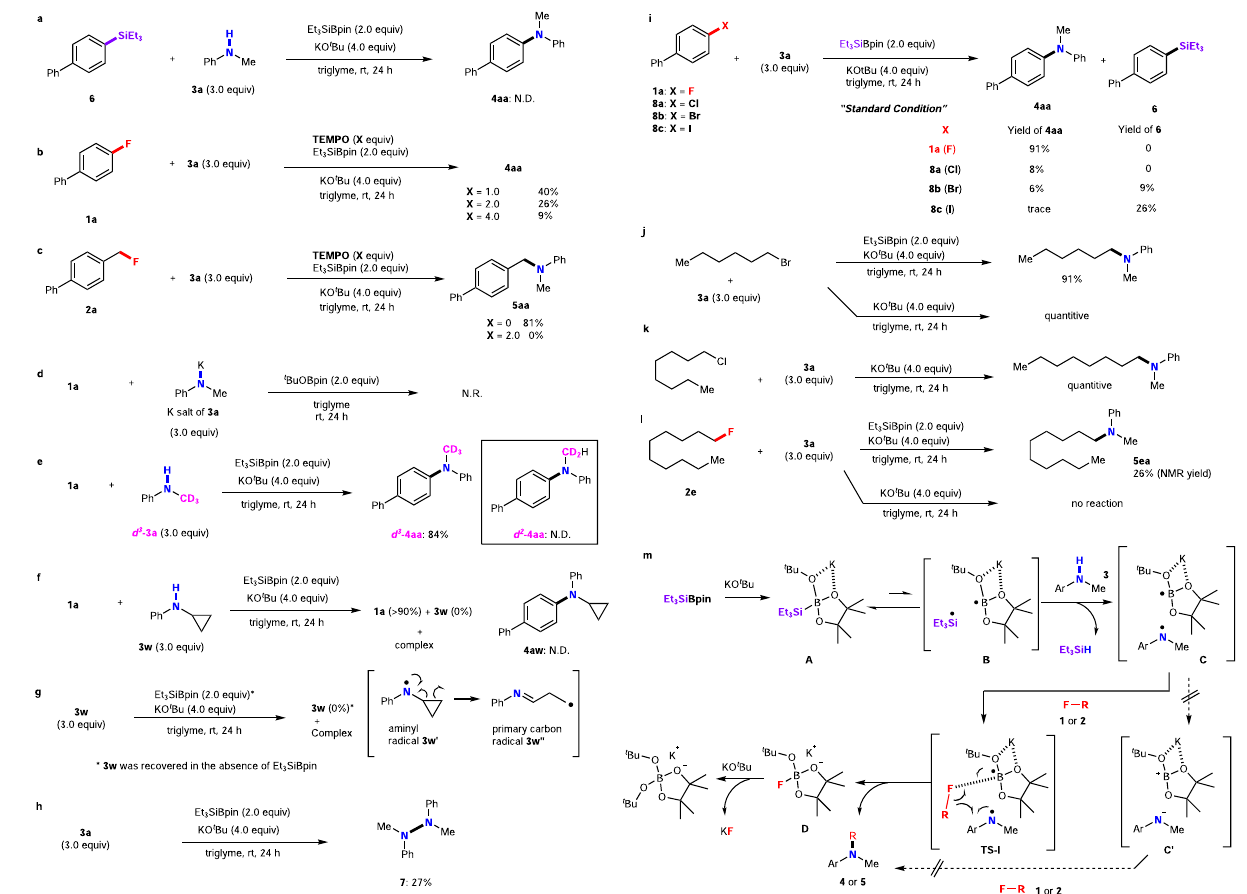
Fig. 4 | Mechanistic studies. a Stepwise attempted reaction. b , c Effect of TEMPO on the silylboronate-mediated coupling reaction. d Reaction of 1a with the potas- sium salt of 3a (PhNKMe) in the presence of t BuOBpin. e Reaction between 1a and thedeuterated 3a ( d 3 - 3a ). f , g Radicalclockexperiments. h